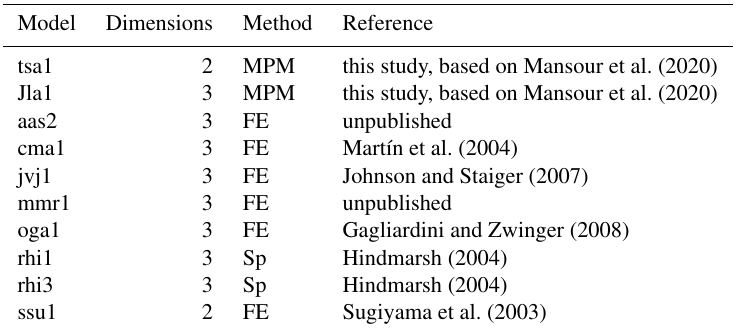
Figure 8. Maximum and minimum values of the horizontal surface velocity ( v x (y s ) ) and of the maximum basal shear stress ( τ xy (y b ) ) in Experiment B and D, plotted for every model size. The underlying FE mesh is fitted to the rock–ice interface. Results are compared to the results of eight full-Stokes models (compiled and published by Pattyn et al., 2008). Abbreviations of the comparison experiments are compiled in Table 3. Table 3. Model abbreviations used in the diagrams, taken from Pattyn et al., 2008. “Dimensions”: model dimensions. “Method”: numerical method: FE: finite element, Sp: spectral method, MPM: material point